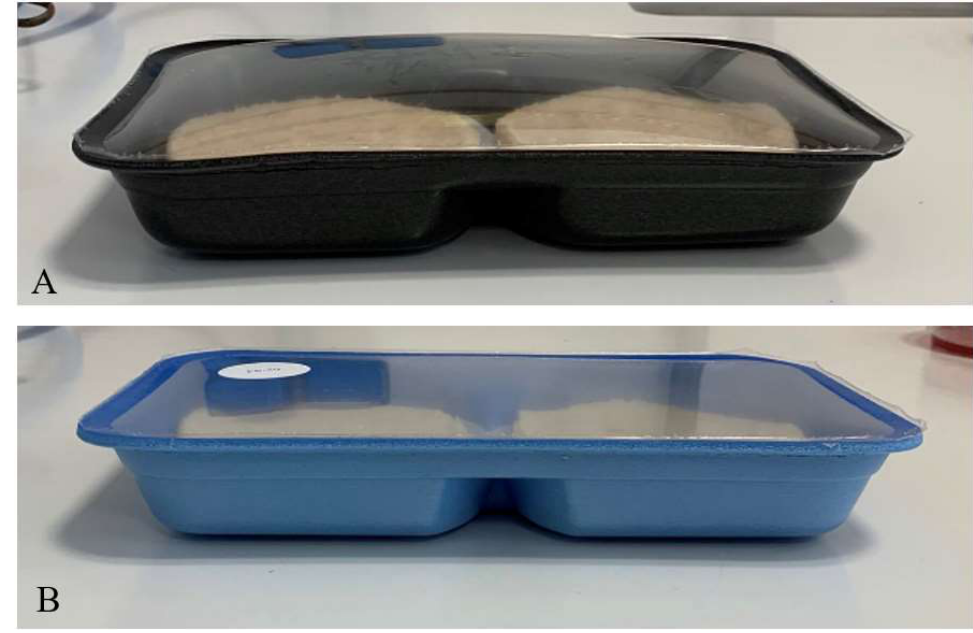
Figure 1. Pictures of the uninoculated ( A ) and inoculated ( B ) fish burgers at 12 days of storage. Table 1. Fate of physico-chemical and microbial characteristics of hamburgers made with a mix of sea bass and sea bream meat.